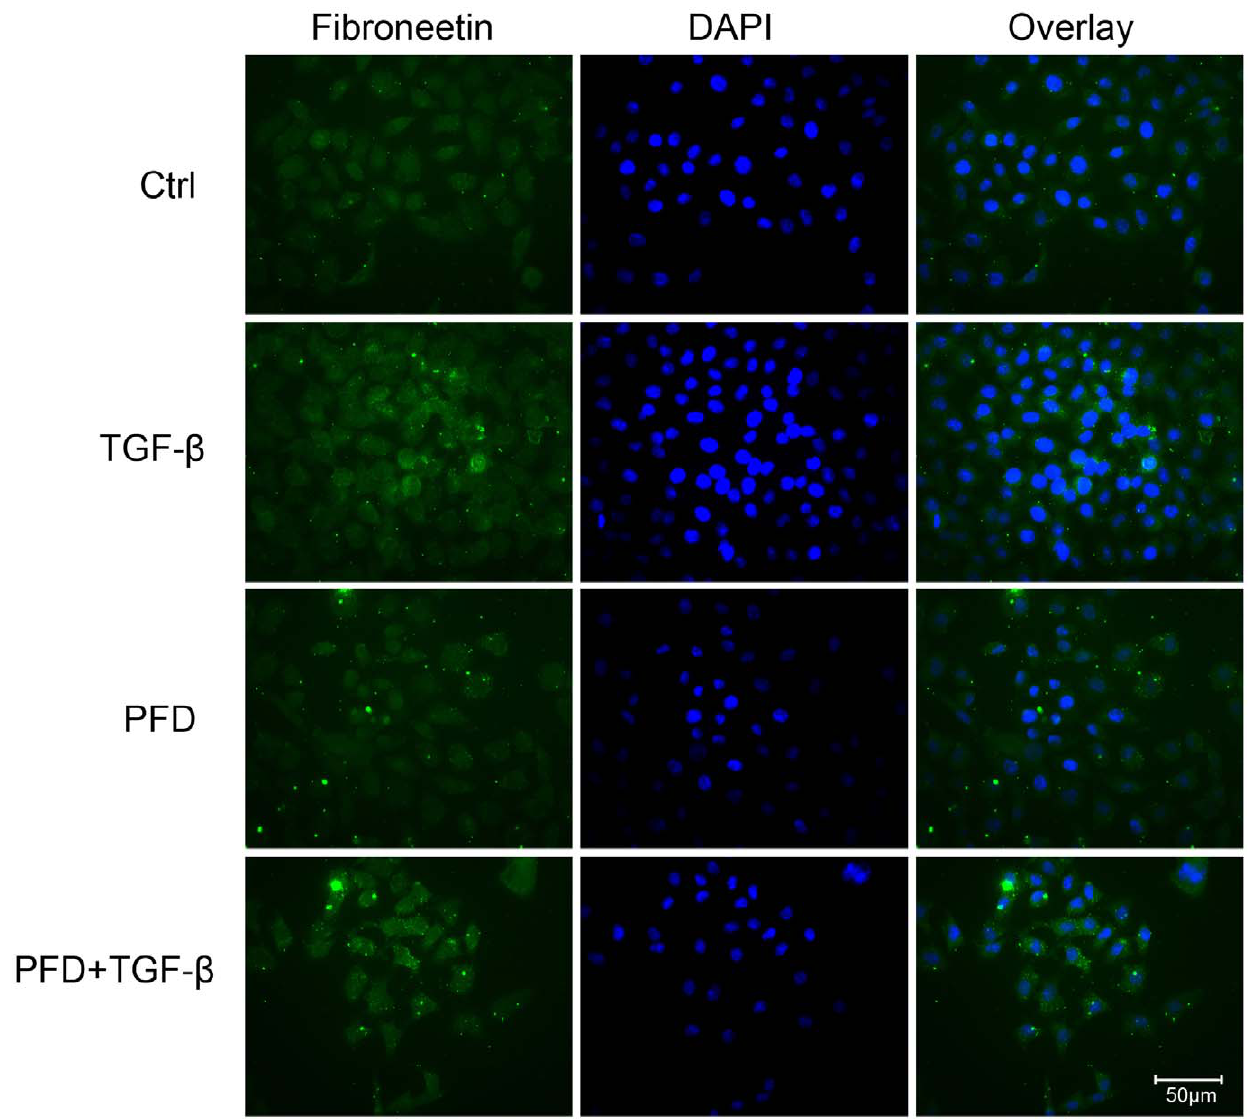
Figure 5. Inhibitory effect of pirfenidone on TGF- b 2-induced epithlial-mesenchymal transition in SRA01/04 cells. Compared with control cells (A), immunocytofluorescence demonstrated that the TGF-beta2 significantly up-regulated the mesenchymal phenotypic marker fibronectin (FN, green) in SRA01/04 cells (C). Either in the absence (B) or presence (D) of TGF-beta2, FN was significantly down-regulated after 24 hours’ treatment with 0.5 mg/ml PFD. The nuclei stained by DAPI (blue). Magnification, 6 400.